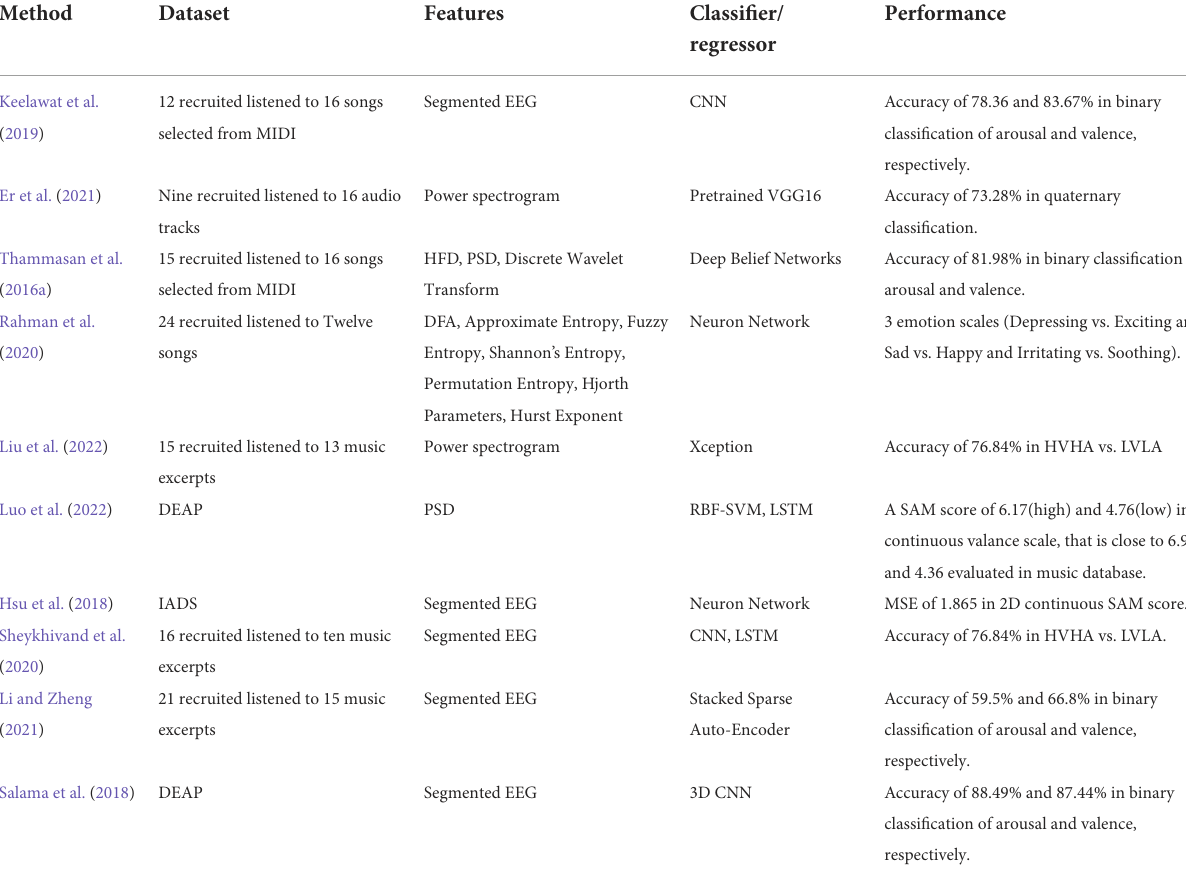
TABLE 4 Details of music emotion recognition algorithms based deep learning